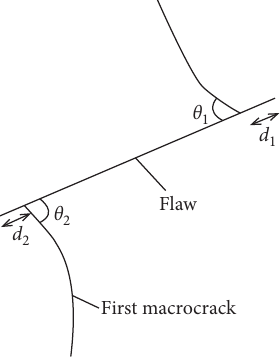
Figure 5: Crack initiation angles and distances between first macrocrack initiation locations and flaw tips